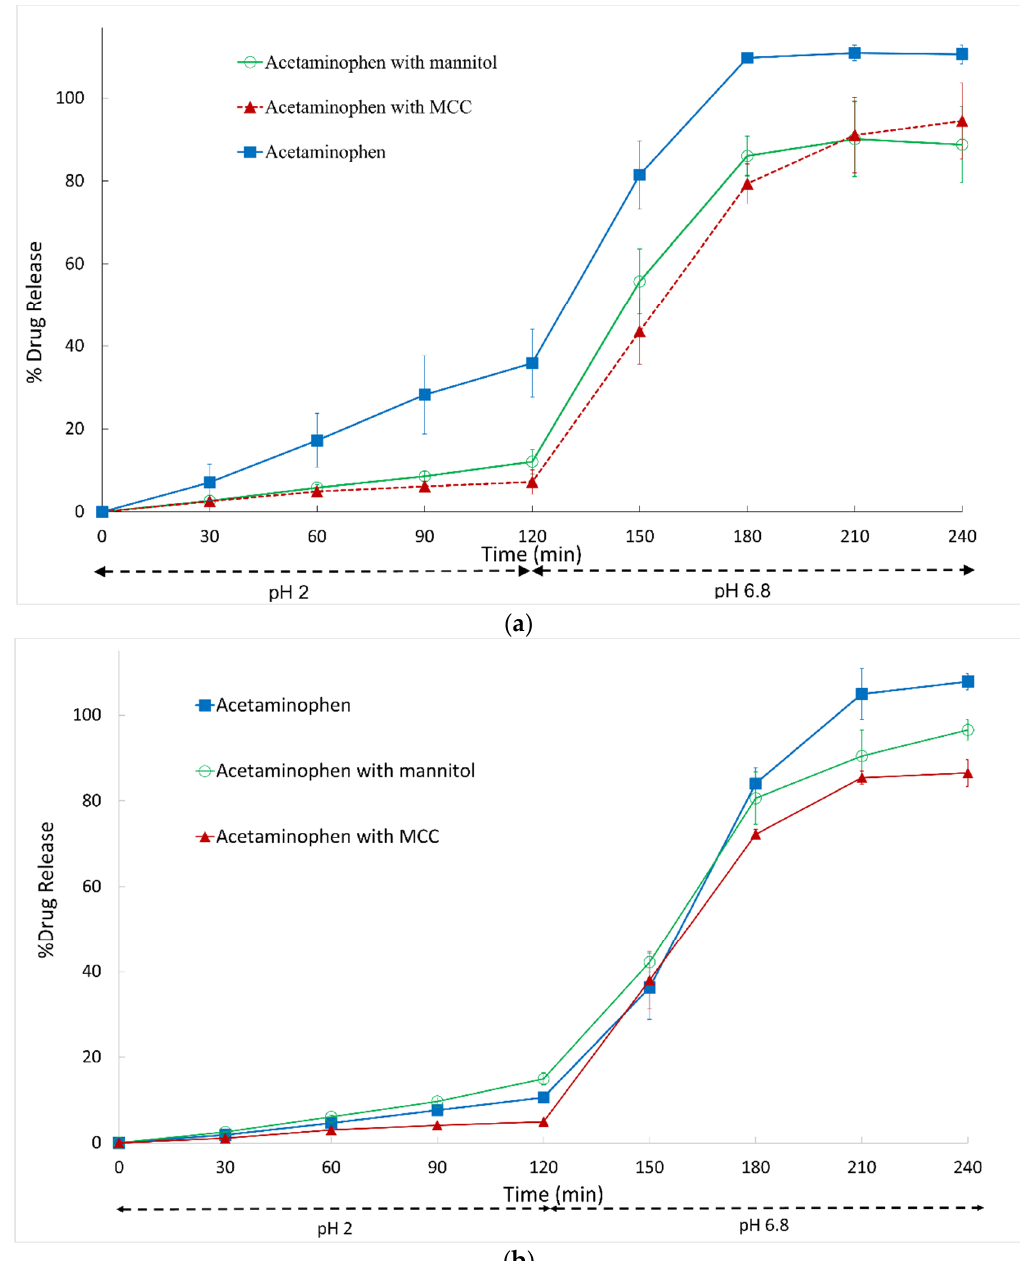
Figure 3. Dissolution profiles of Vcaps ® Enteric capsules filled with acetaminophen only or acetaminophen with diluent: ( a ) acetaminophen 20 mg with or without 280 mg diluent; ( b ) acetaminophen 100 mg with or without 200 mg diluent. Data shown as drug release mean % ± SD.